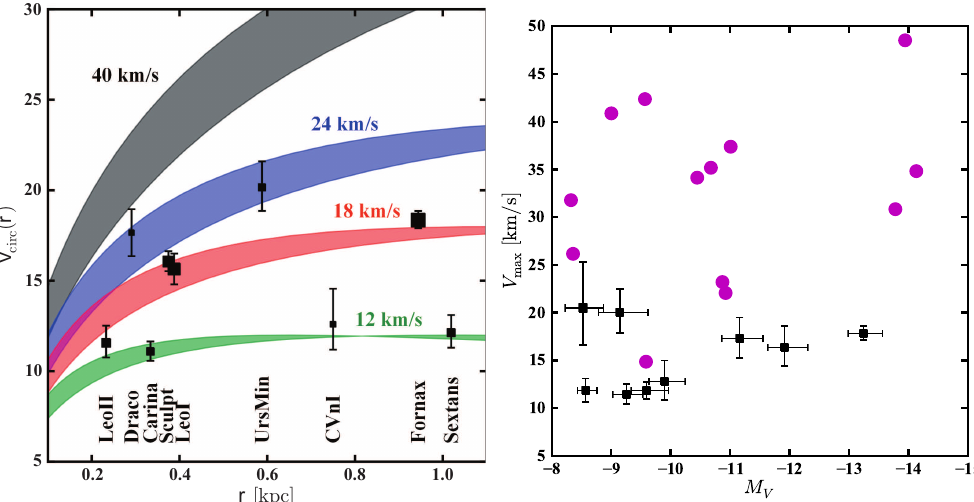
Figure 14. Left panel: rotation curves for NFW subhaloes with V max = ( 12,18,24,40 ) km/s ± 1 σ from Aquarius simulations, confronted with the bright dSphs, represented by the dots with error-bars. Right panel: V max vs. M V , the visual magnitude, for the same bright dSphs (black dots with error-bars) and the most massive subhaloes of the Aquarius simulations (magenta dots). The observed dSphs are much less massive than the simulations (panels reproduced from